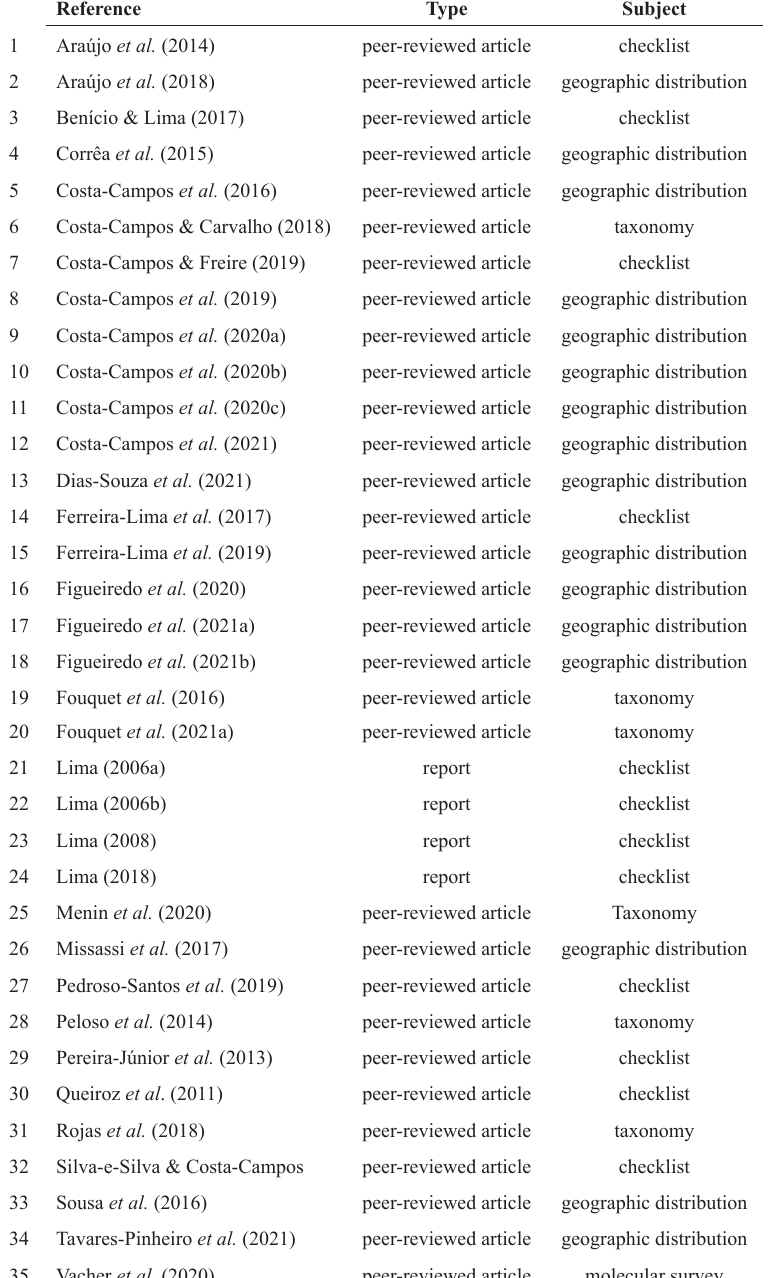
Table 1. Literature records used to complete the anuran checklist from the state of